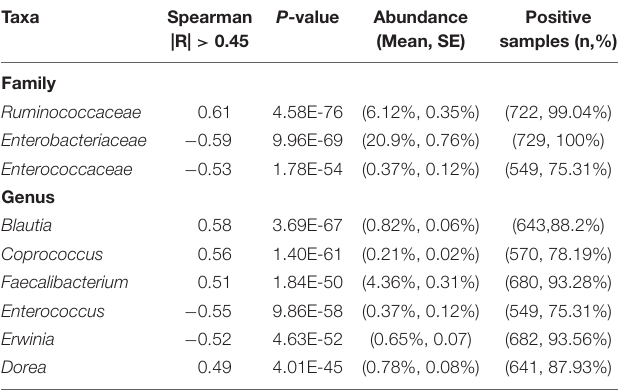
TABLE 2 | Taxa in the gut microbiome that significantly correlate with age.